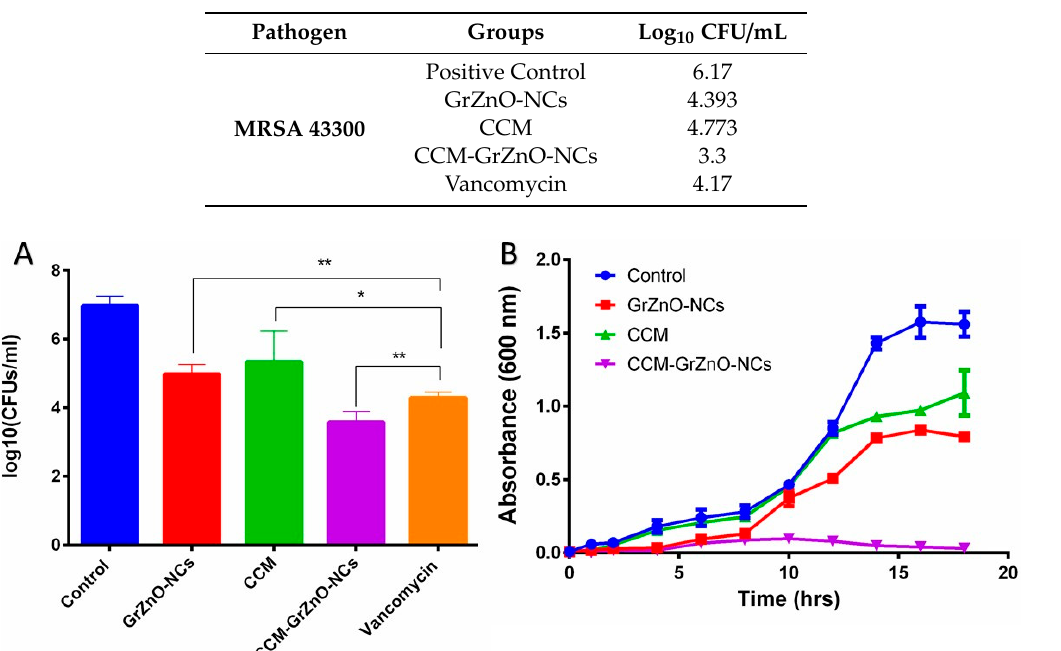
Table 2. Bacterial load in terms of log10 CFU/mL to assess residual MRSA ATCC 43300 survived in response to treatment with various GrZnO-NCs based formulations.